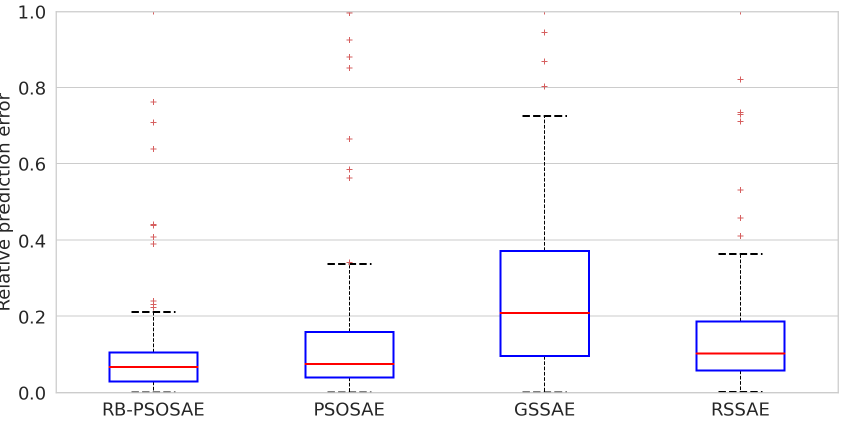
Figure 7. Relative prediction error of testing results for the debutanizer column process using RB-PSOSAE, PSOSAE, GSSAE, and RSSAE search